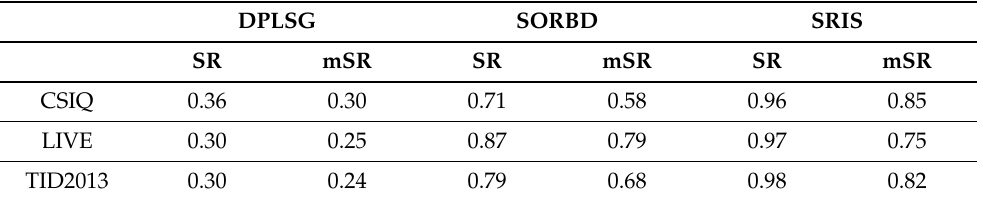
Table 4. The average size proportion of salient regions over all the images.